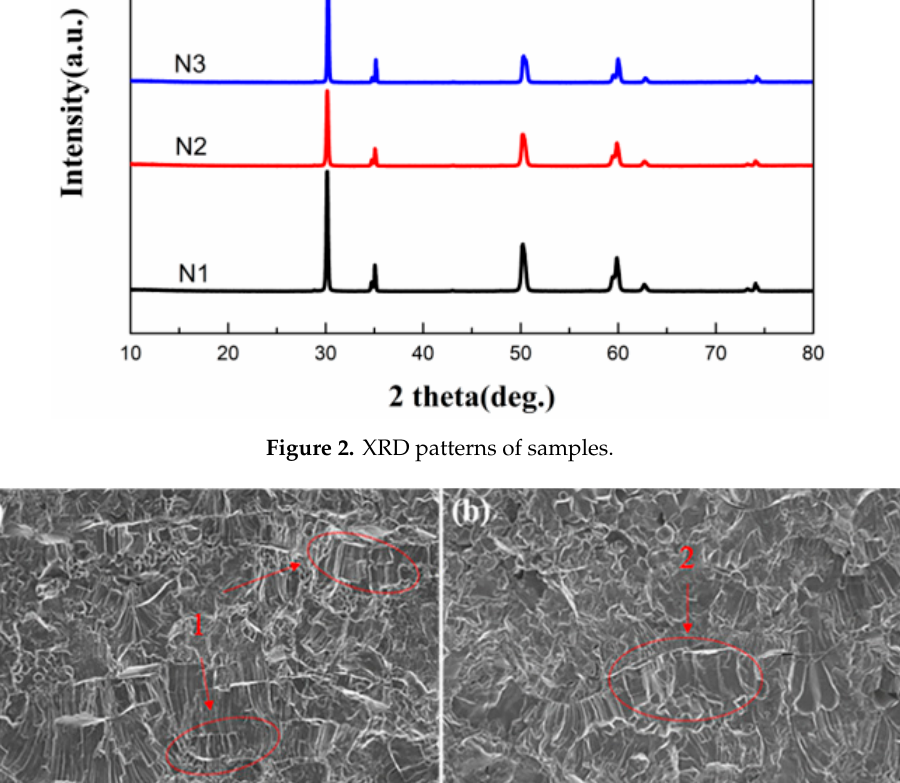
Figure 2. XRD patterns of samples.